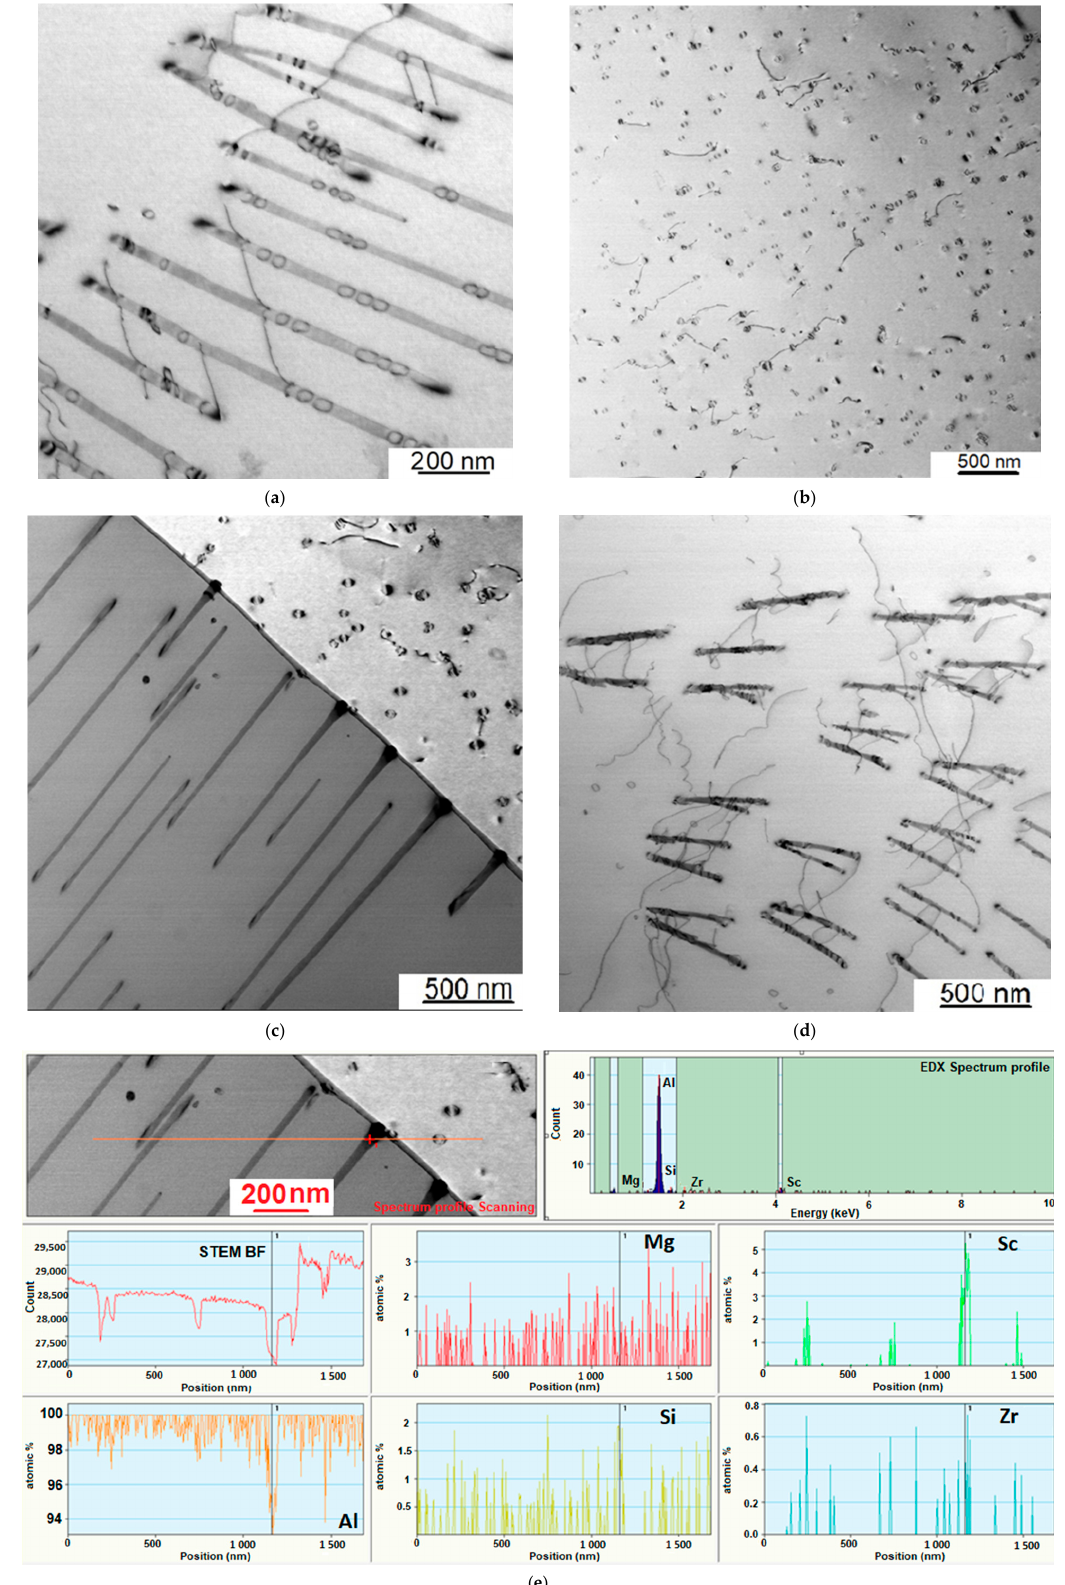
Figure 12. ( a,c,d ) Discontinuous precipitation of (AlSi) 3 ScZr needle-shaped particles; ( b ) (AlSi) 3 ScZr particles with the L1 2 -structure, ( c ) discontinuous precipitation of (AlSi) 3 ScZr needle-shaped particles near high-angle boundaries. ( e ) EDS profile line scan.